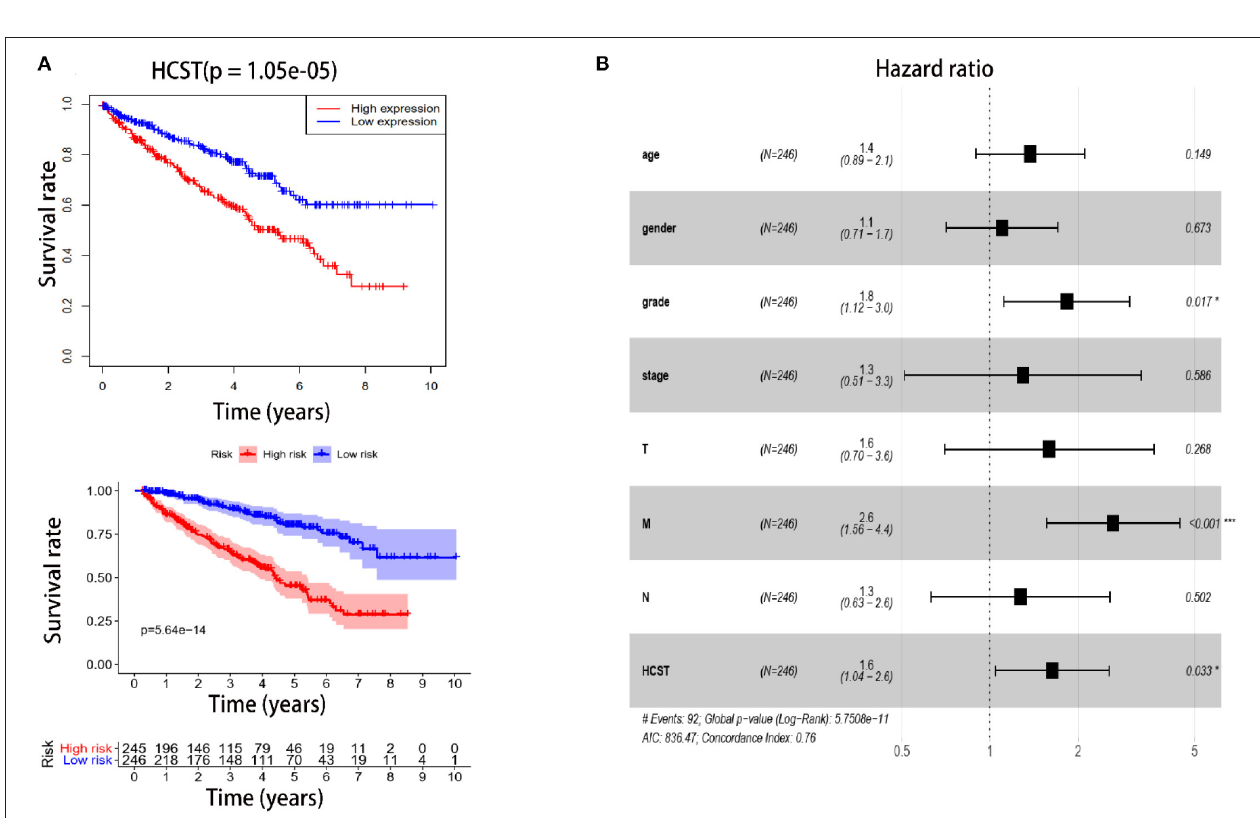
FIGURE 6 | High HCST expression is associated with poor survival of ccRCC patients. (A, Upper ) OS of HCST (high) and HCST (low) ccRCC patients matching the TCGA database from R version 4.0.2 software. (A, Down ) DFS of HCST (high) and HCST (low) patients from the GEPIA2 matching TCGA and GTEx data. ( B) Multivariate Cox analysis showing the hazard ratios of different factors. The number of events for the number of tested factors was 92. The global p -value (log-rank) was 5.7508e − 05, Akaike’s information criterion was 836.47, and the concordance index was 0.76.